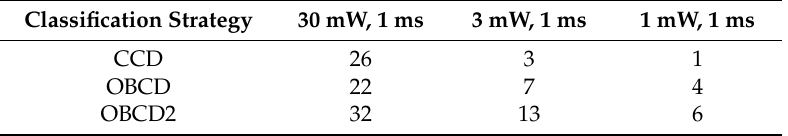
Table 1. The table compares the resolution of the linear discriminant analysis (LDA) histograms of acetone and benzene produced by different classification strategies and using different laser